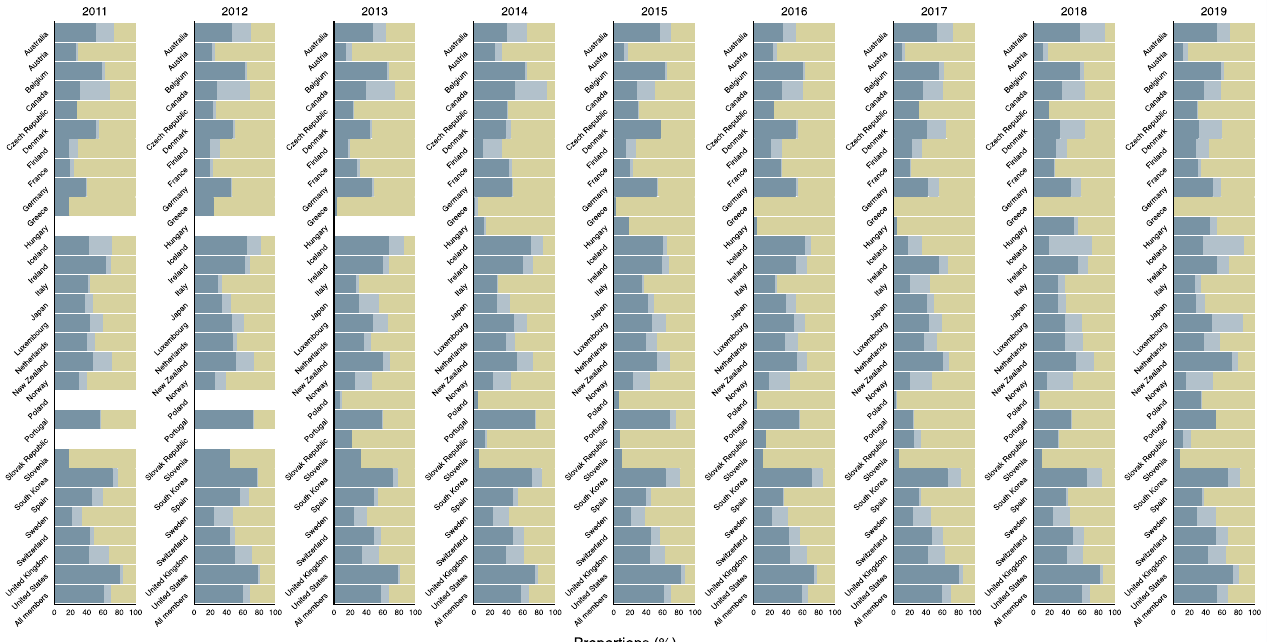
Figure 3. Estimated DAH from all the 29 DAC member countries by development type, 2011–2019. Blue: bilateral aid (excluding bi-multi); Light blue: bi-multi aid; Yellow: multilateral aid; DAH: development assistance for health; DAC: Development Assistance Committee.